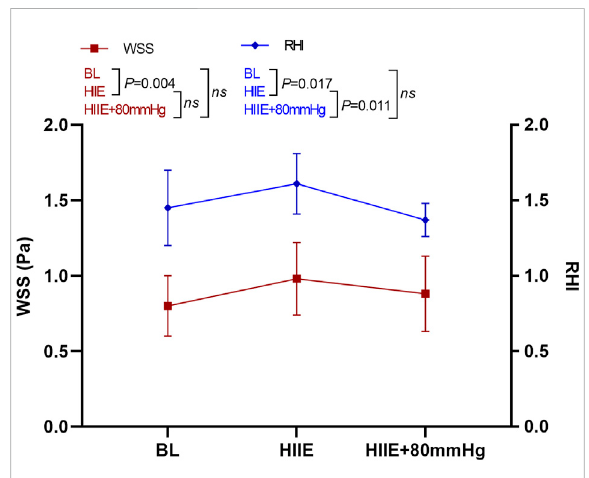
FIGURE 5 Changes in RHI and WSS at baseline after HIIE and HIIE